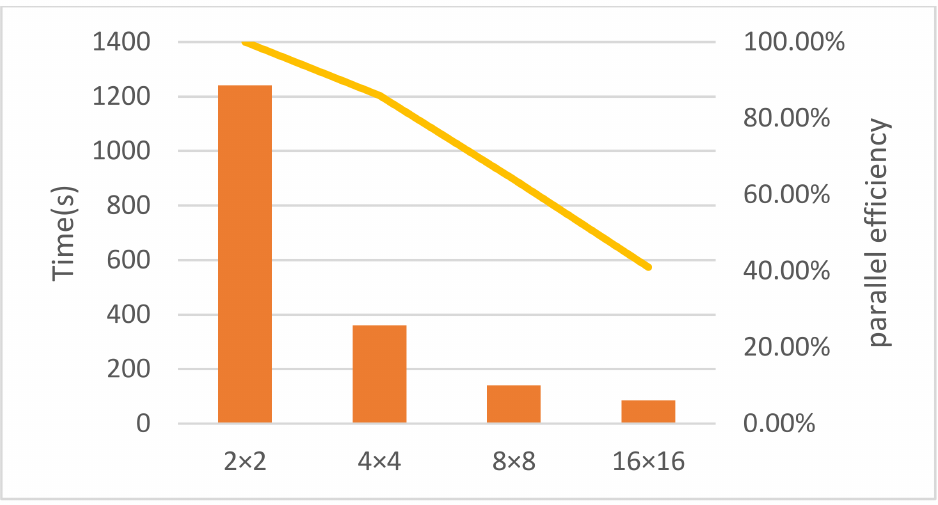
Figure 13. Optimized heterogeneous parallel strong scaling test. In the first section, we mentioned that Bhadke et al. also proposed a computing framework for solving PDE using GPU. However, according to our calculation method of parallel efficiency, the parallel efficiency calculated according to the speedup results provided by them is not ideal. For example, the speedup ratio calculated based on the grid size of 1000 (10 × 10 × 10) in their article, the speedup ratio also increases with the increase of the grid size, but the parallel efficiency is only below